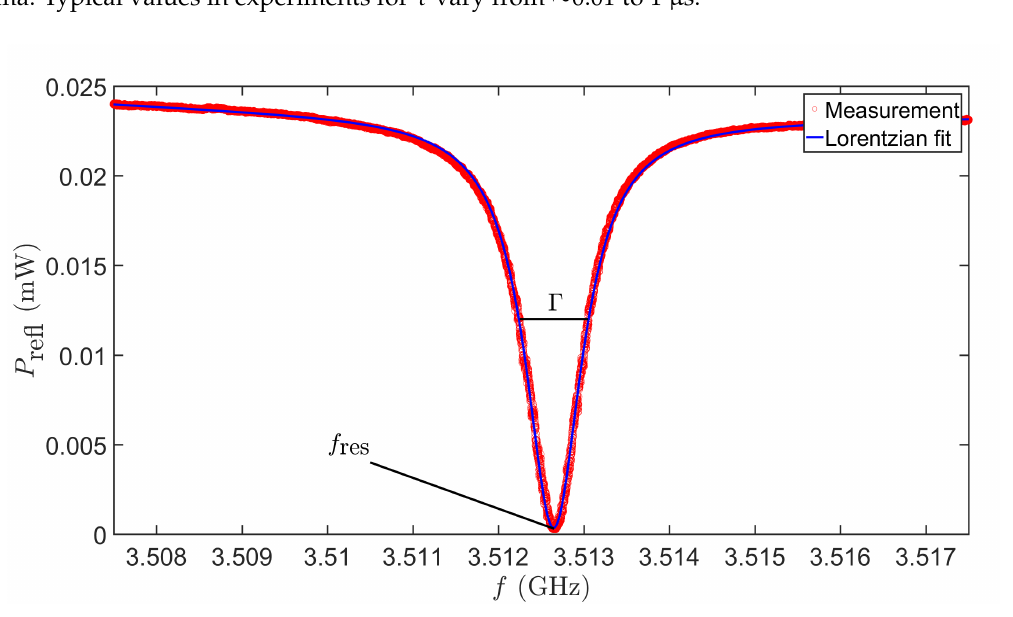
Figure 2. Spectral response of the TM 010 resonant mode of the unperturbed cavity measured in reflection configuration (red marks) and a Lorentzian fit (blue